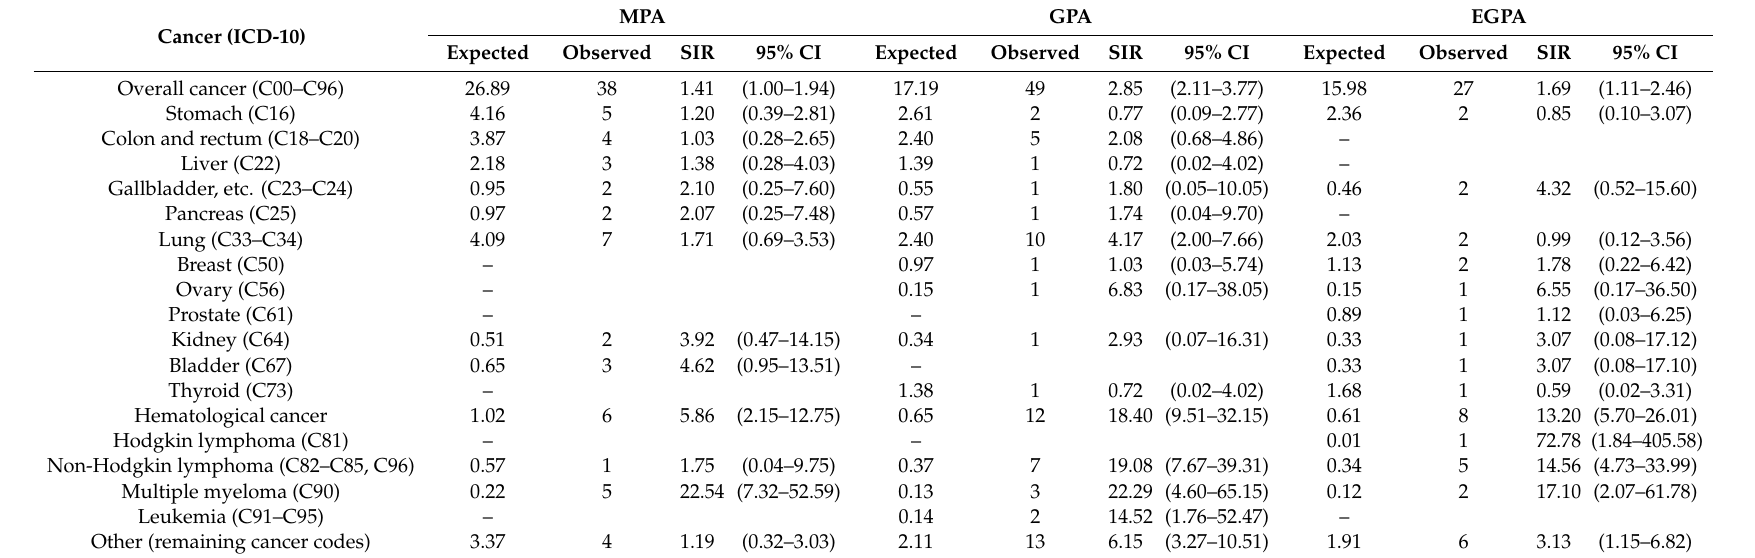
Table 4. Cancer-specific risk based on subgroups of